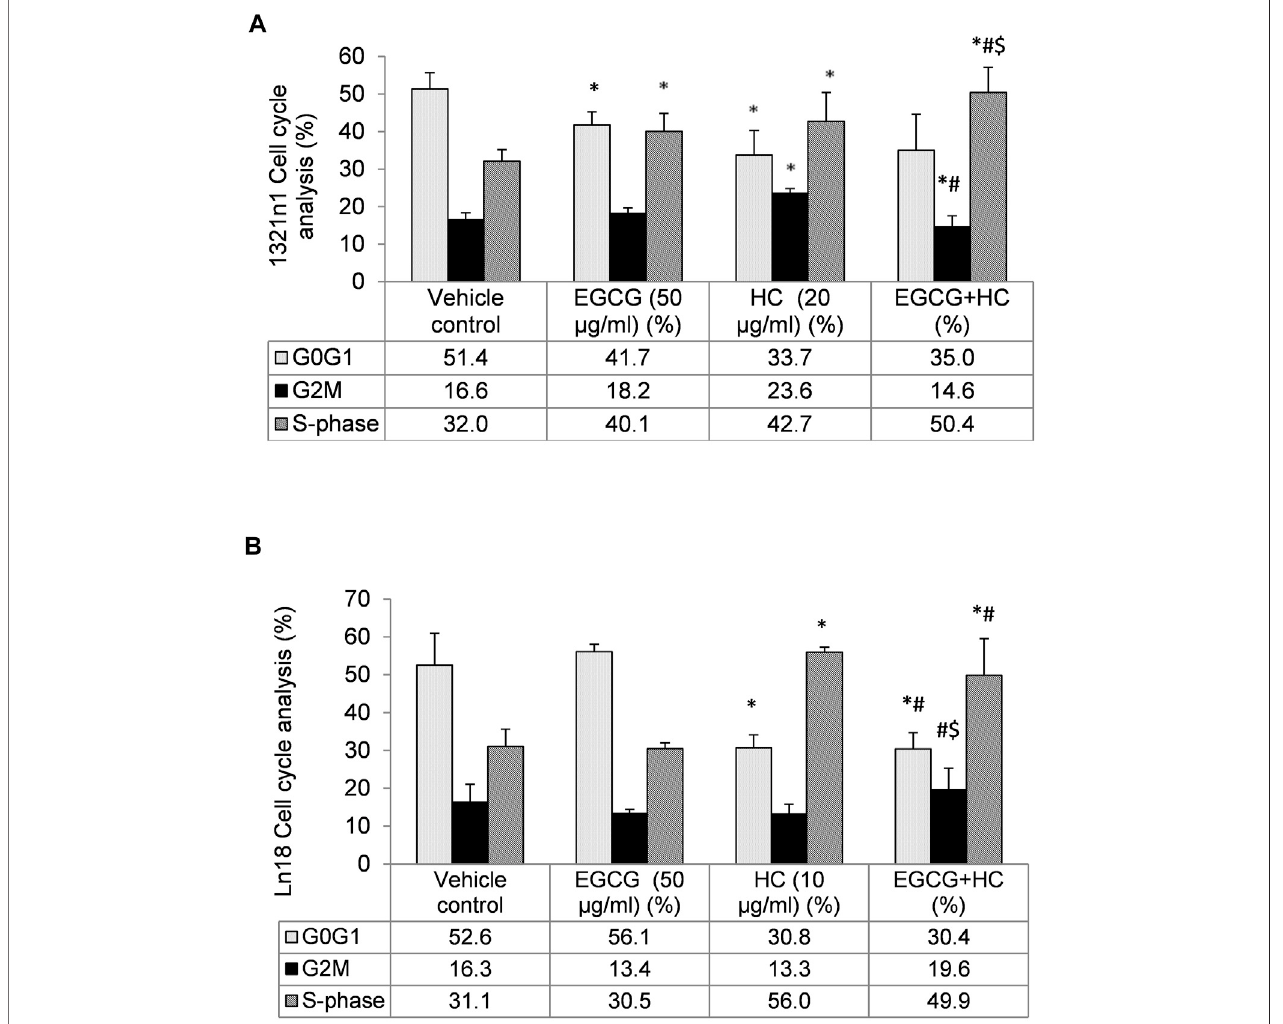
FIGURE6| Thedistributionof (A) 1321N1and (B) LN18cellsinthecellcyclephases.Thedataindicatethemean±SD( n =3).* p < 0.05comparetovehiclecontrol, # p < 0.05 compare to EGCG, $ p < 0.05 compare to HC.